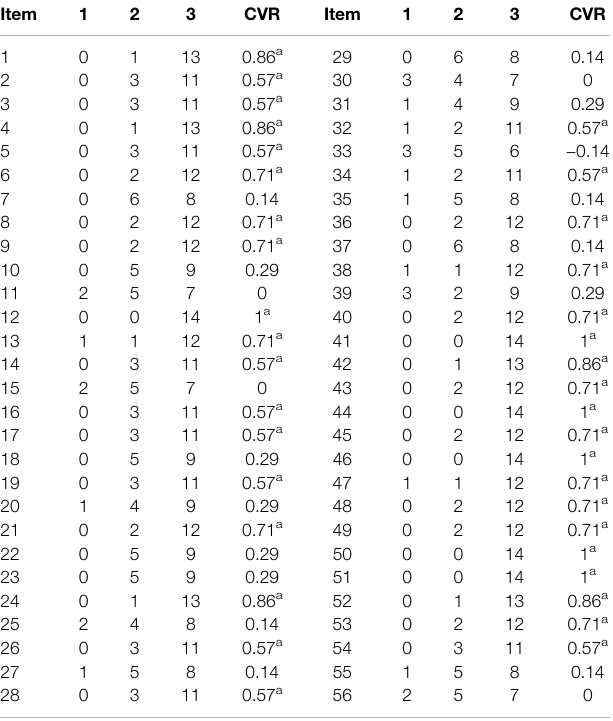
TABLE 1 | Expert scores and CVR for each